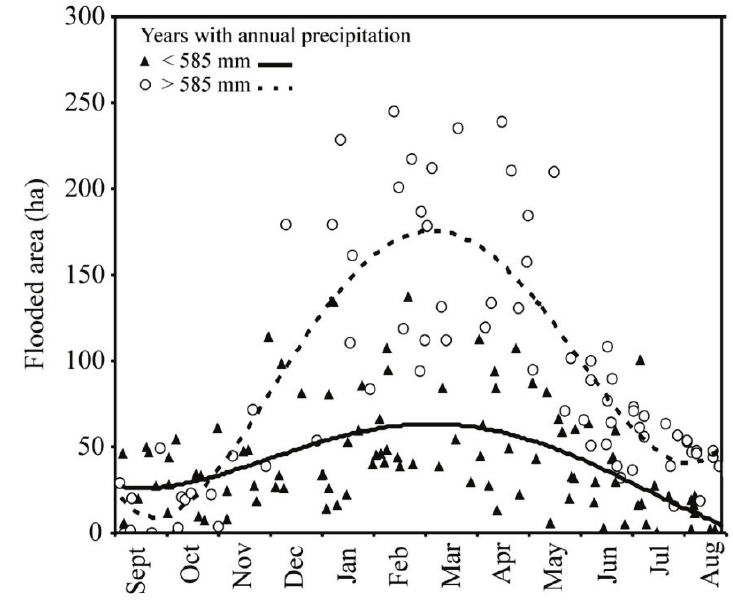
Figure 6. Synoptic characterization of intra-annual variation of flooded area as obtained from pooling pond model predictions from the entire time-series data